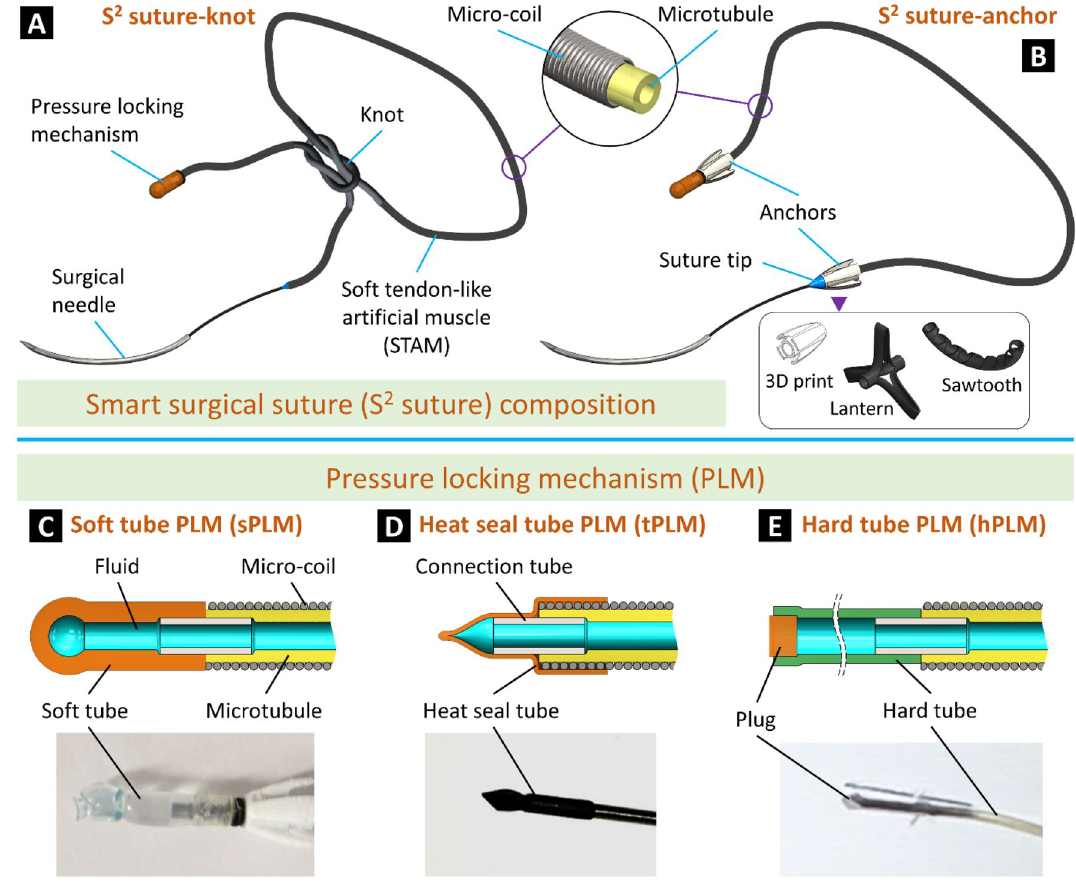
Figure 2. Structure of the smart surgical sutures (S 2 sutures). ( A ) The S 2 suture-knot can be knotted as conventional surgical sutures. ( B ) The S 2 suture-anchor formed by combining the S 2 suture-knot with